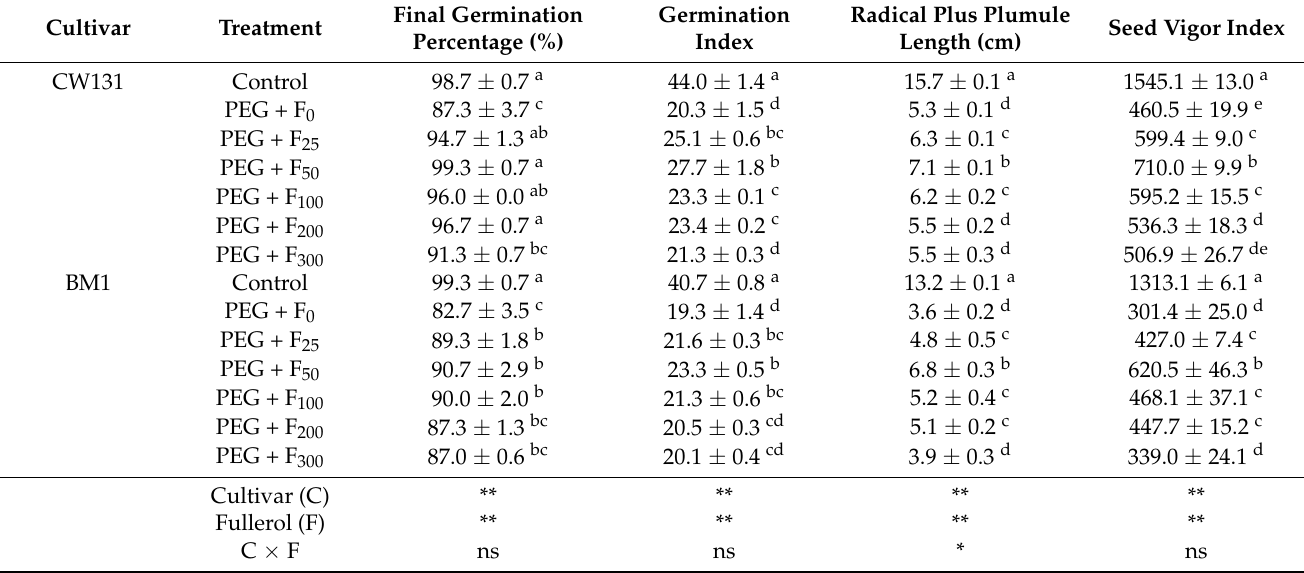
Table 1. Effect of different fullerol additions (concentrations range from 0 to 300 mg L −1 ) on the seed germination parameters of two wheat cultivars (CW131 and BM1) under PEG ( 20% polyethylene glycol) treatment.